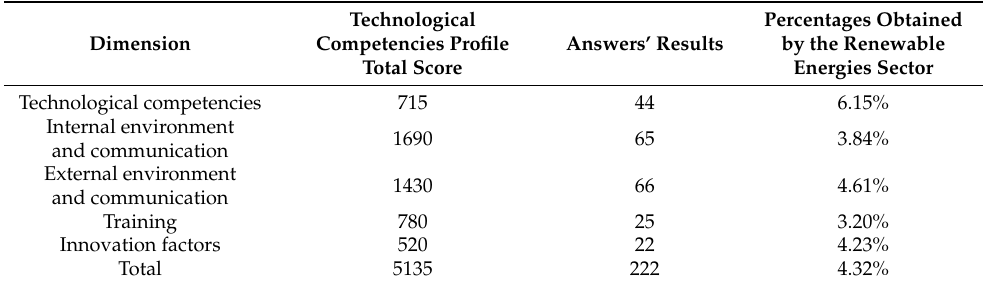
Table 4. Evaluation of the Technological Competencies Profile in the renewable energies sector of Baja California.